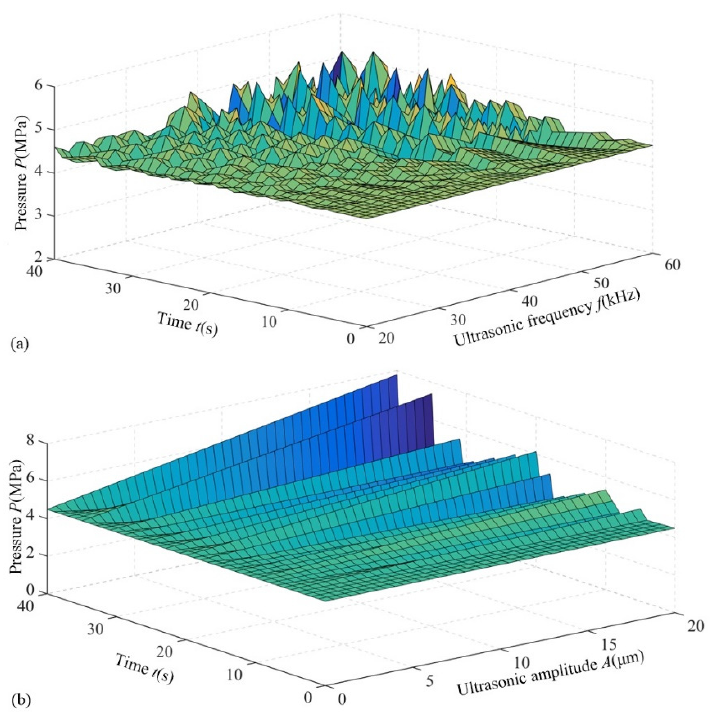
Figure 2. Variation of ultrasonic sound pressure. ( a ) Ultrasonic frequency; ( b ) Ultrasonic